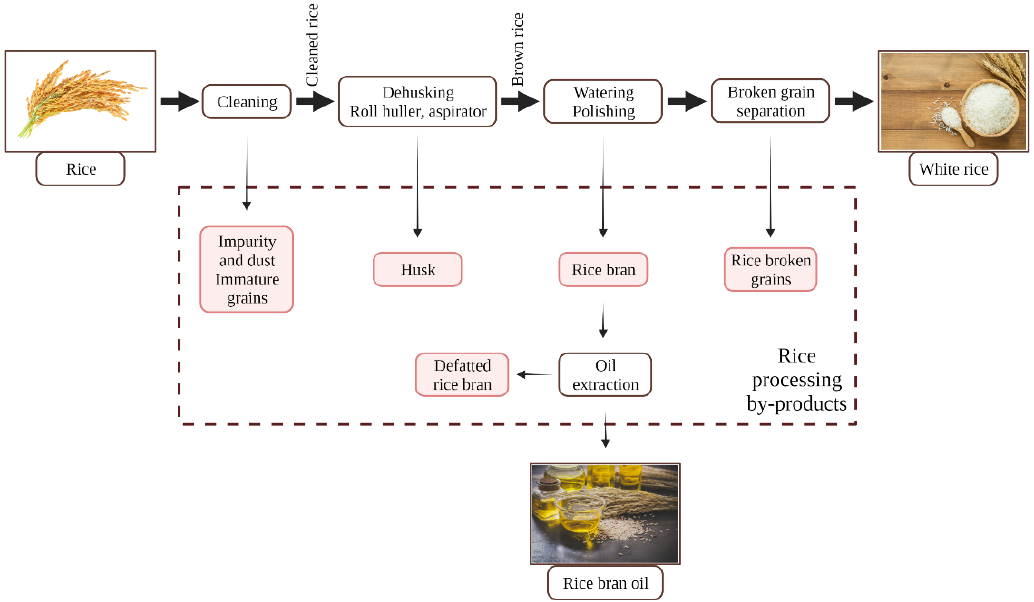
Figure 4. Types of by-products resulted after rice processing [11].